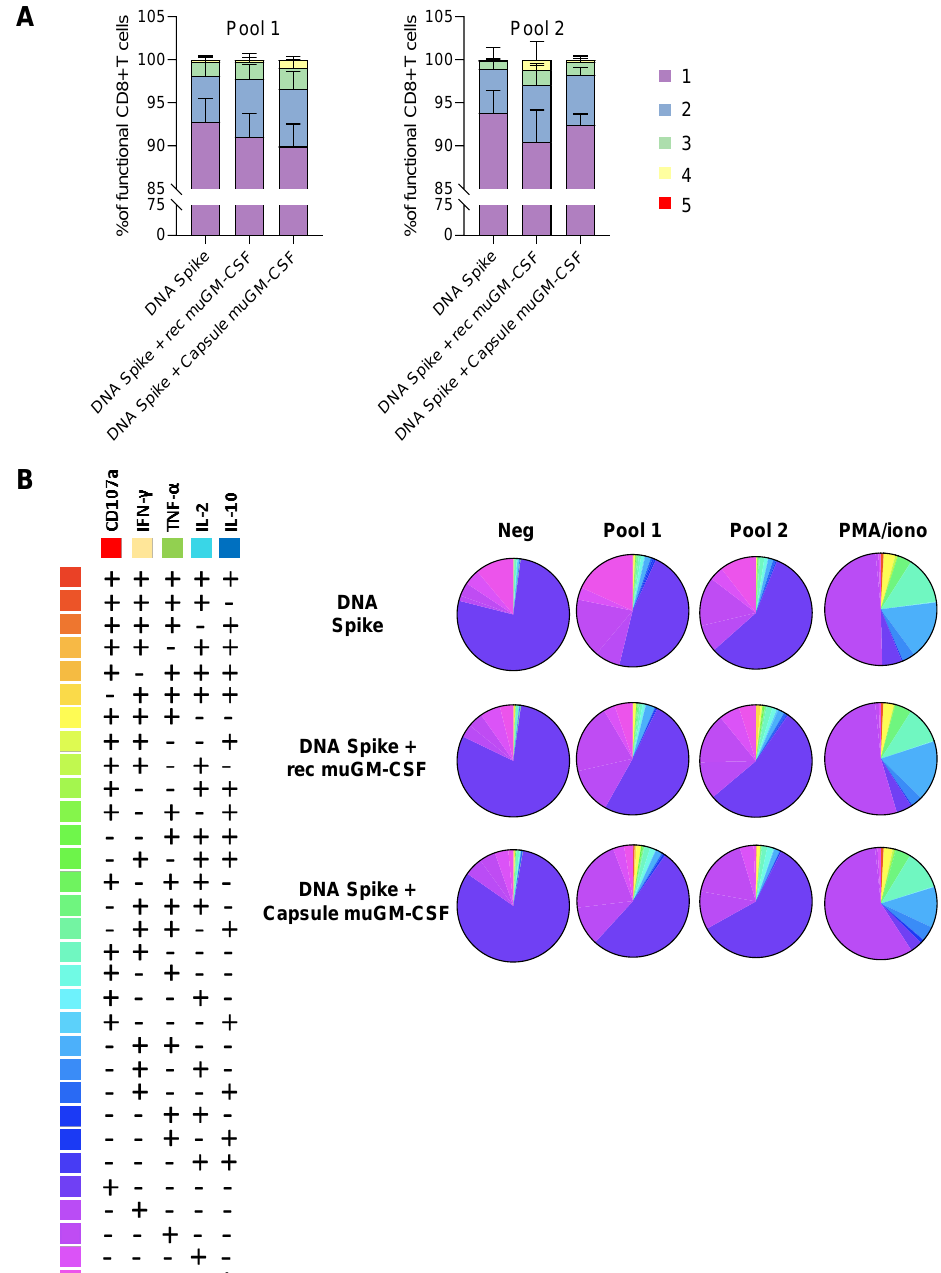
Figure 3. Polyfunctionality of Spike-specific CD8+ T cells at day 10 post-vaccination. ( A ). Histogram representing the percentage of functional CD8+ T cells with 1, 2, 3, 4 or 5 functions after pool 1 and pool 2 stimulation. ( B ). Pie charts representing the proportion of responding CD8+ T cells expressing different combinations of cytokines and degranulation markers after stimulation with spike peptide pool 1 or pool 2, PMA/ionomycin (positive control) or DMSO (negative control) stimulation. Histograms and Pie charts represents the mean of 5 animals per group.